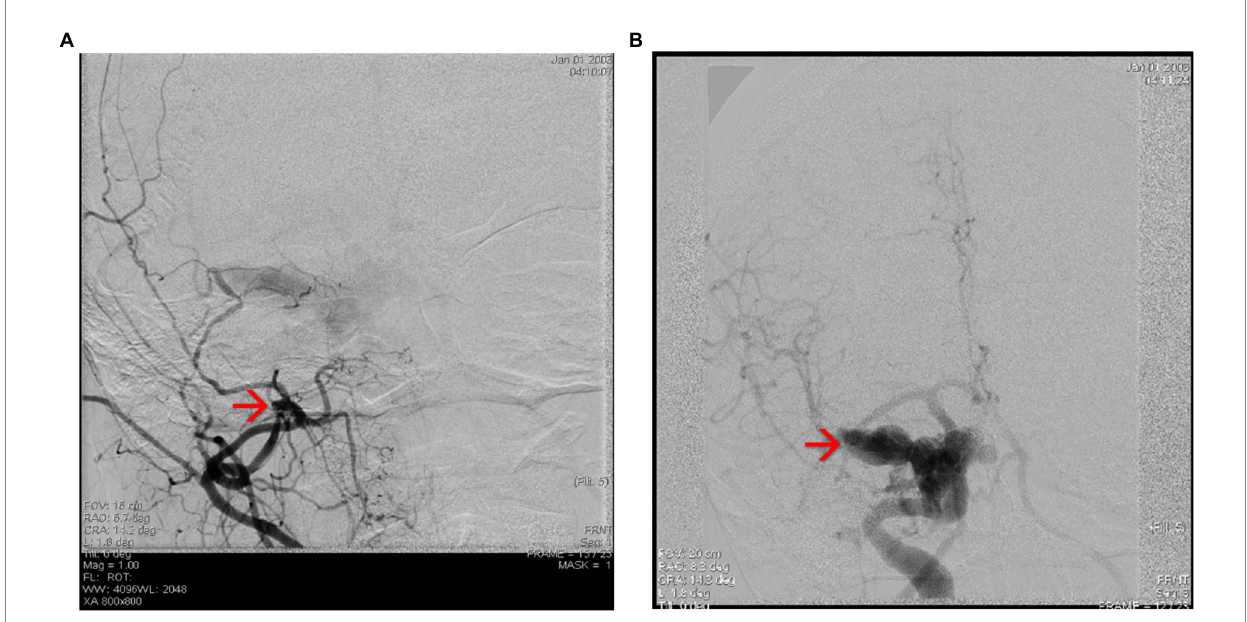
FIGURE 5 (A,B) Cerebral angiography highlighting the Type D carotid-cavernous fistula [according to Barrow classification (4)] on the right side, and dural shunts between both branches from the external carotid artery (ECA) ant the internal carotid artery